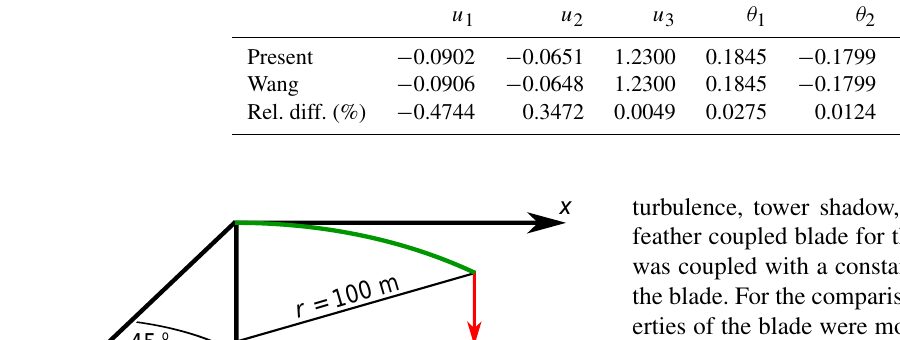
Table 2. Tip displacements and rotations (in Wiener–Milenkovic parameter) of a coupled cantilever obtained with the present model com- pared to results by Wang et al. (2014).